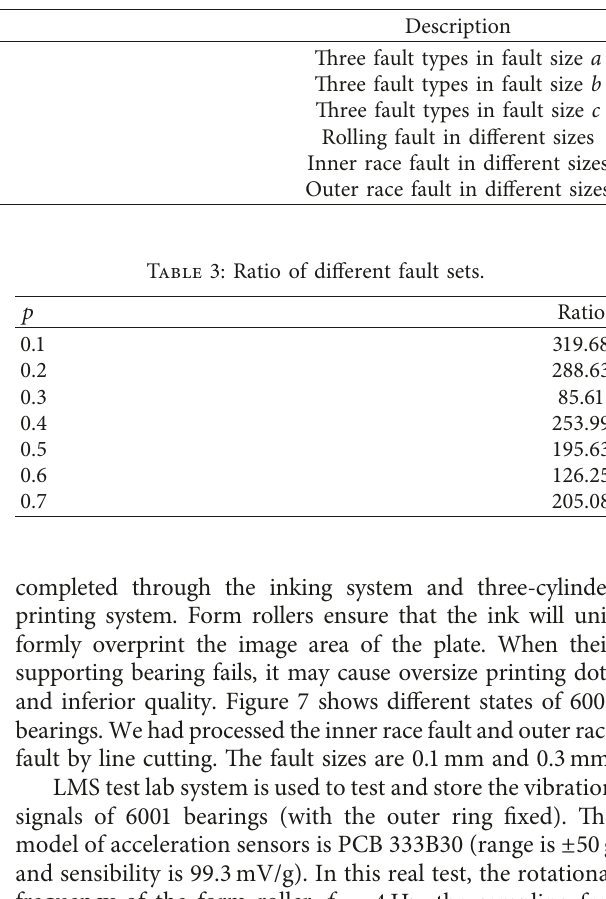
Table 2: Faulty samples divided into 6 groups.